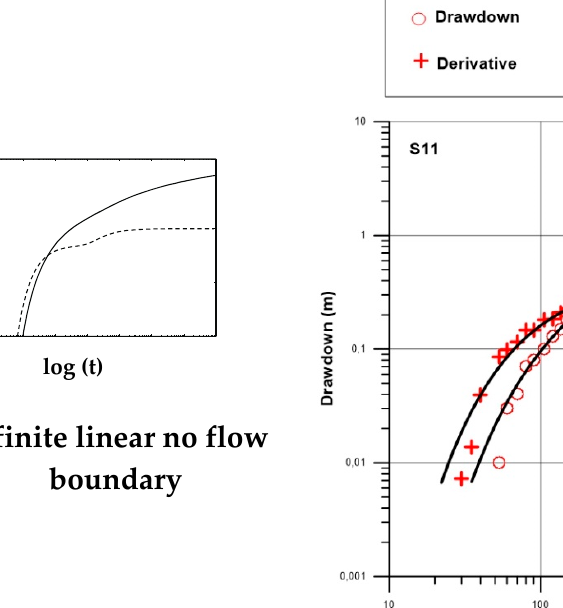
Figure 12. Interpretation of pumping test S10/S11: diagnostic plot ( left ) and data superimposed with a fitted Theis model ( right ).